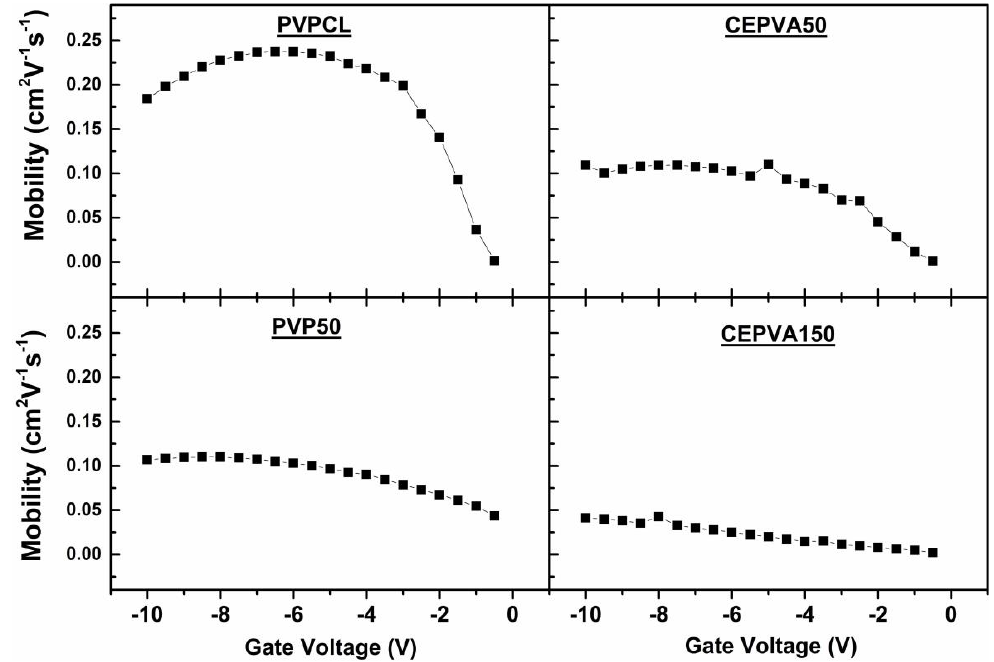
Figure 5. Dependence of charge carrier mobility on the applied gate voltage for OFETs with various kinds of dielectric layers.